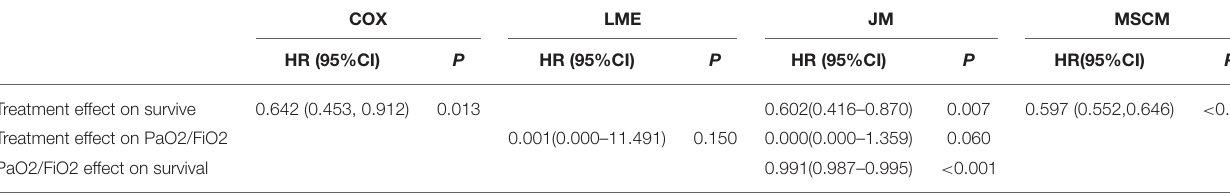
TABLE 2 | Result of effects between two sub-models, joint model and marginal structural cox